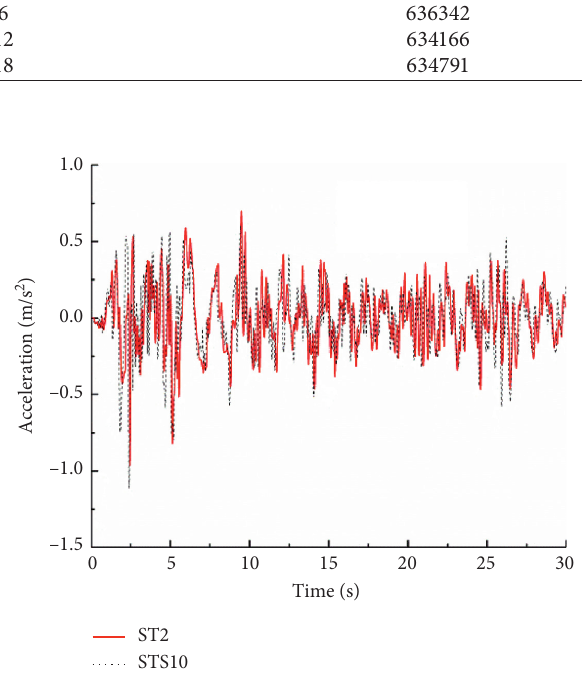
Figure 15: Acceleration at the top of the tunnel. Table 8: Acceleration at the top of the tunnel under different